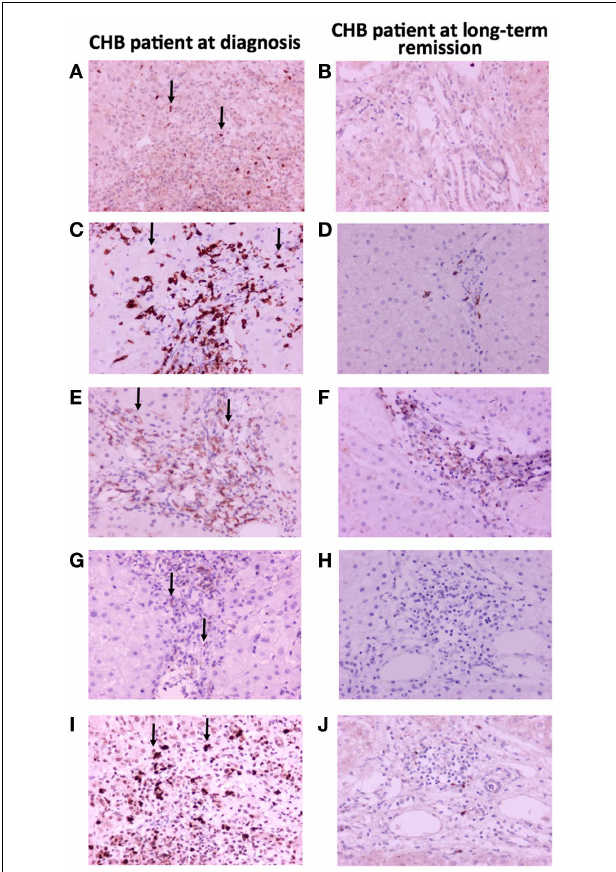
FIGURE 3 | Immunohistochemical findings in liver biopsy specimens from a patient with CHB with marked necroinflammatory activity and a patient on maintained long-term remission . (A,B) FOXP3 immunopositivity in occasional lymphocytes; (C,D) CD8 antigen immunopositivity in many lymphocytes located in portal tracts and hepatic lobules before treatment, contrasted with rare positive lymphocytes after treatment; (E,F) CD4 antigen immunopositivity in some lymphocytes located in portal tracts; (G,H) PD1 immunopositivity in occasional lymphocytes; (I,J) PDL1 immunopositivity in several